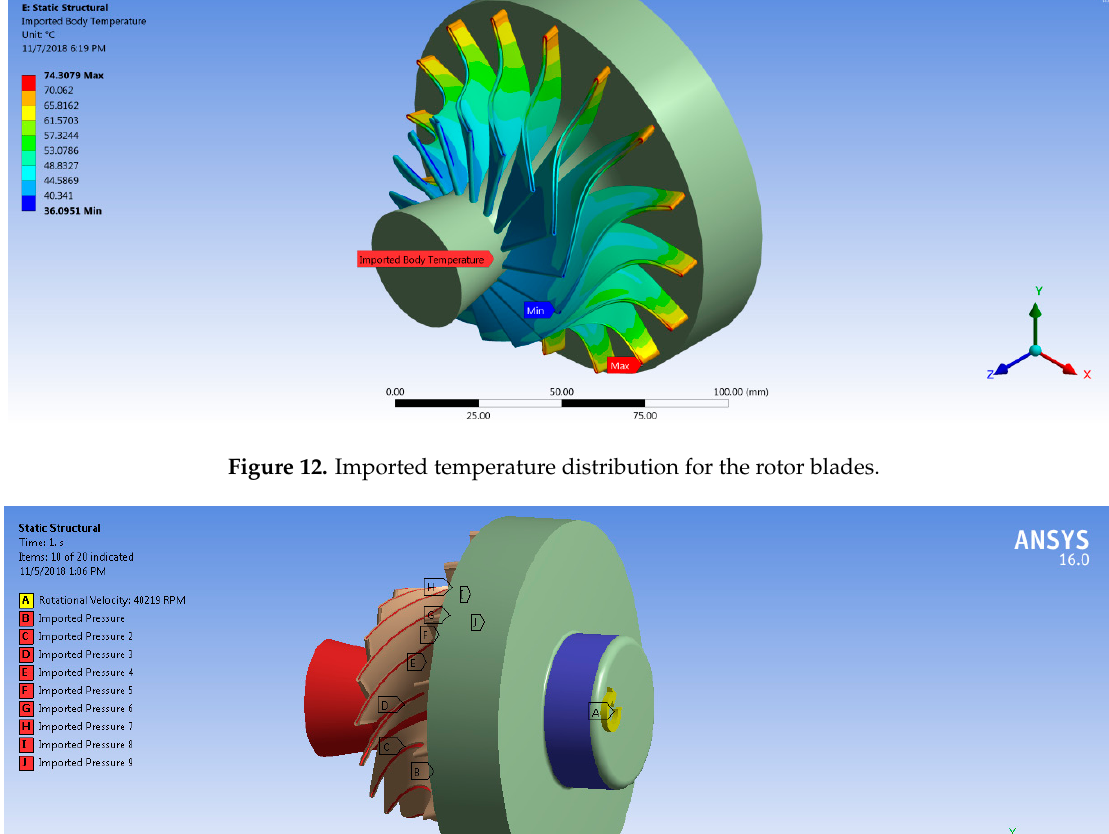
Figure 11. Imported pressure on the rotor blades and the wheel hub. Biomimetics 2019 , 4 , 27